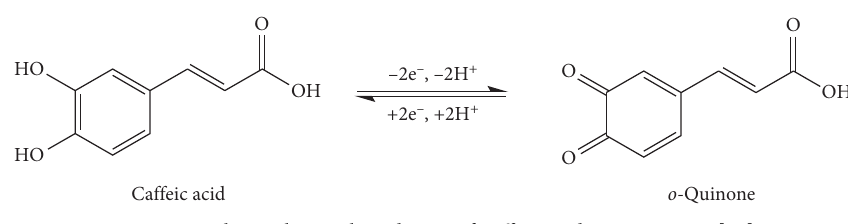
Scheme 1: Electrochemical oxidation of caffeic acid to o -quinone Table 2: Characterization of the main compounds of the apricot pomace extract using their spectral characteristic in HPLC-DAD-MS. Peak